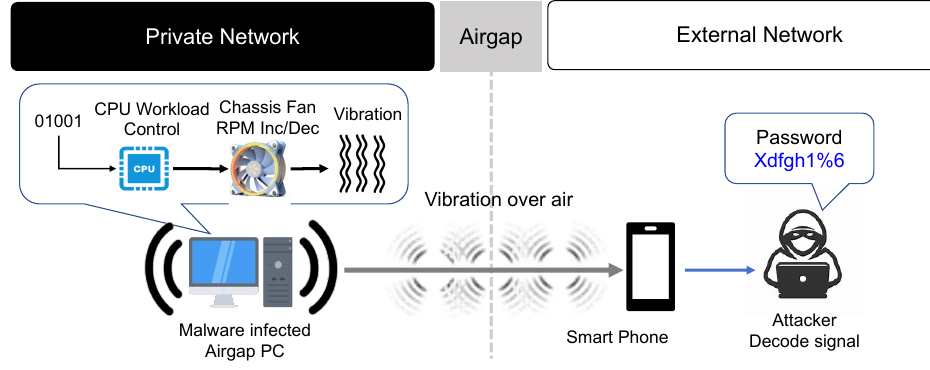
Figure 14. Air-gap attack using vibrations generated from PC fans attached to the PC